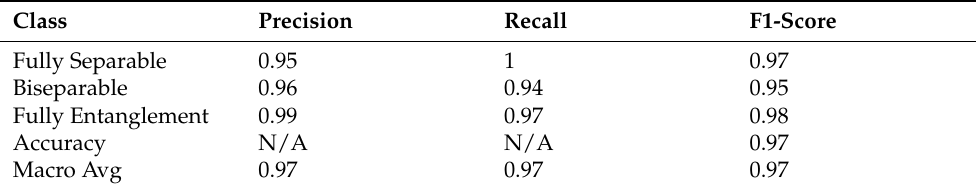
Table 3. Classification report for the Bell-DNN ( 8,3,80 ) model trained with Svetlichny features for pure tripartite quantum